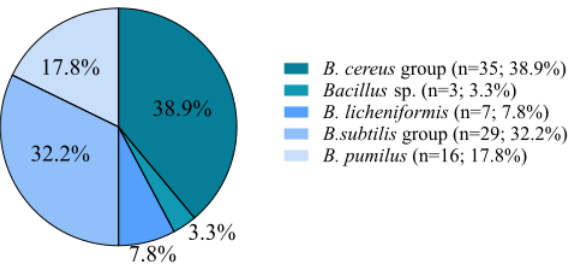
Figure 1. Distribution of Bacillus spp. isolates in di ff erent farm types ( n = 90) .